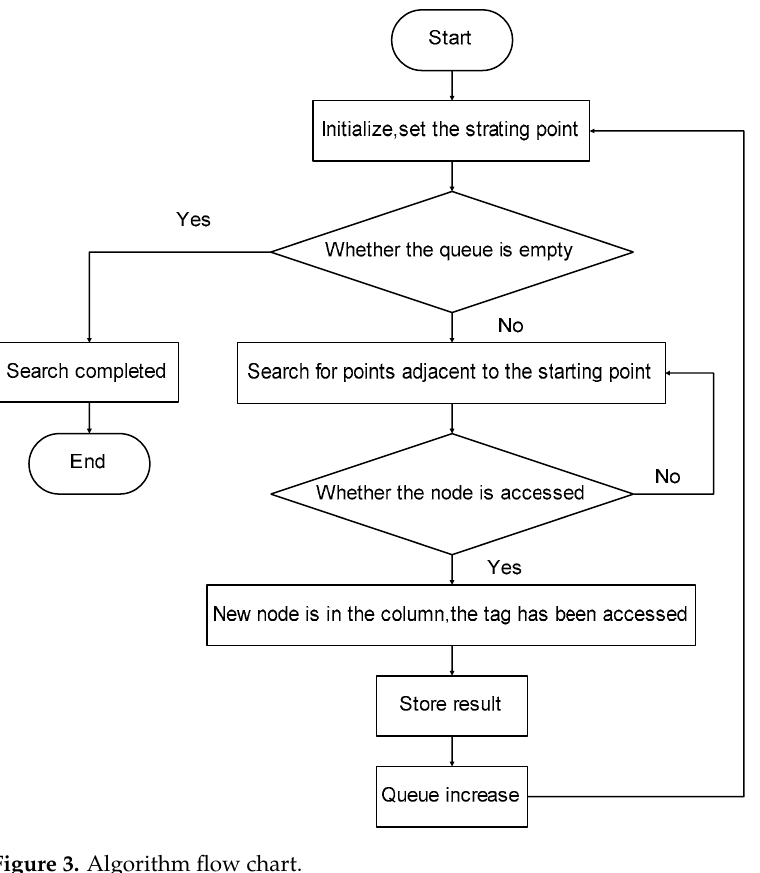
Figure 3. Algorithm flow chart.